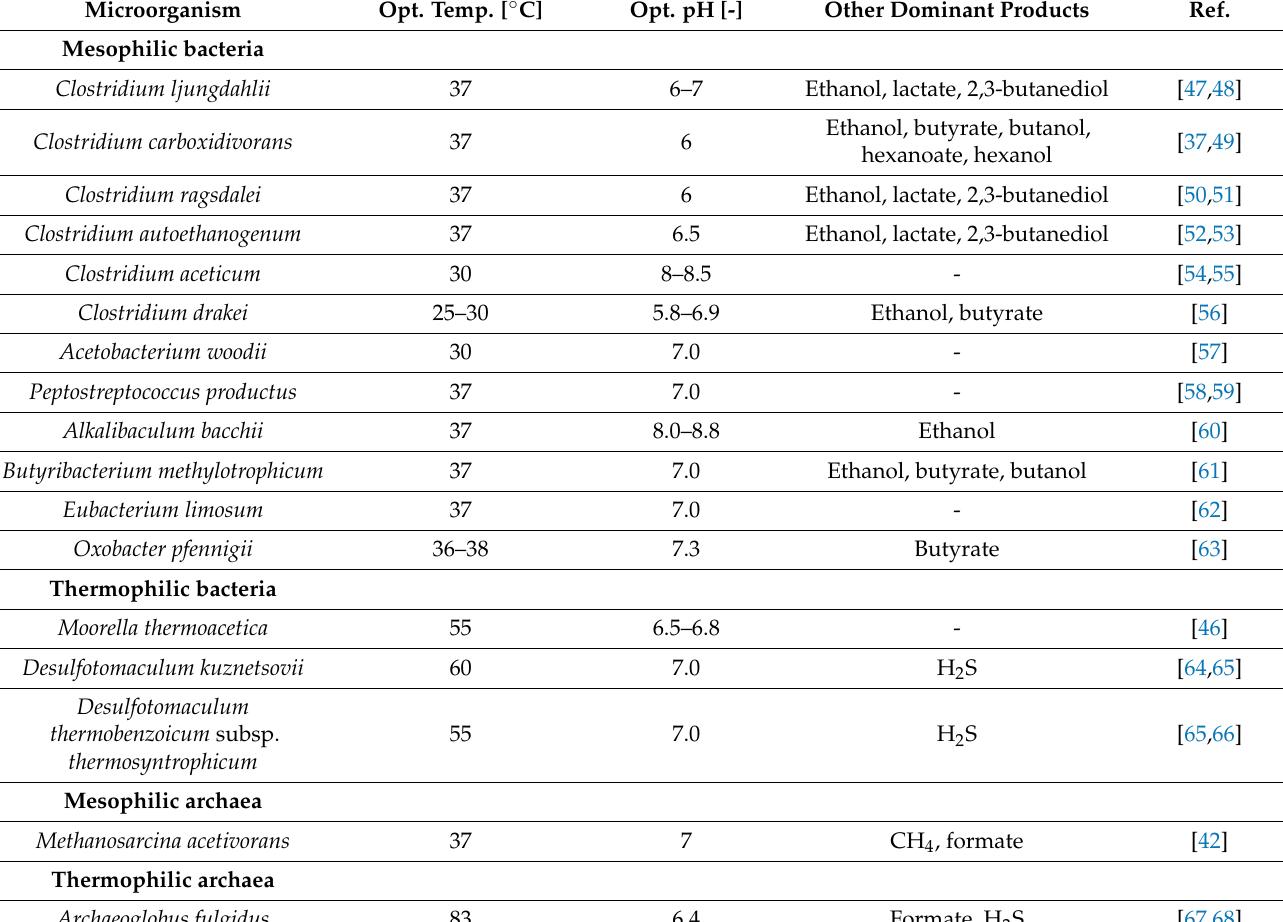
Table 1. Carboxydotrophic microorganisms.